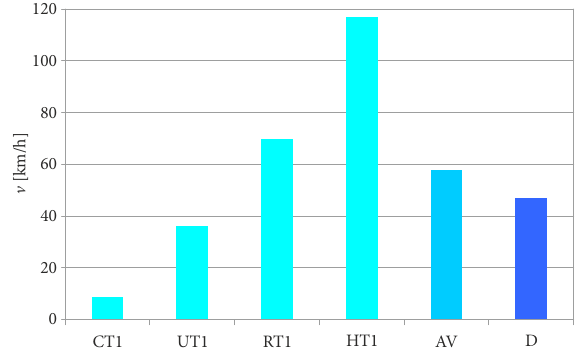
Figure 10. Average vehicle speed v AV in individual tests (CT1, UT1, RT1, HT1) as well as the average value AV and the standard deviation D of the average vehicle speed in all the